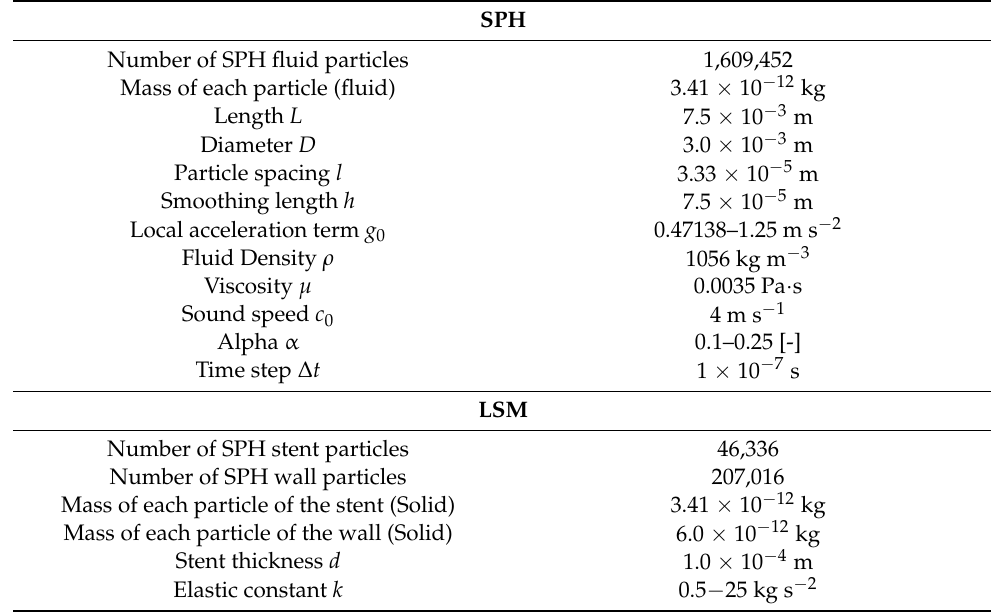
Table 1. Parameters used in the simulation.